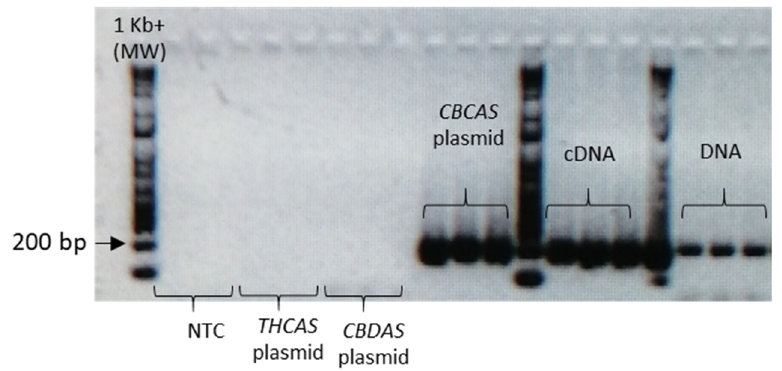
Figure A4. Specificity of primers for CBDAS . The expected amplification band of 241 bp was obtained from pJET1.2 containing the CBDAS and DNA from hemp and from CINRO. Amplification was not obtained from pJET1.2 plasmid containing the THCAS and CBCAS . Primers work only on functional CBDAS sequences.